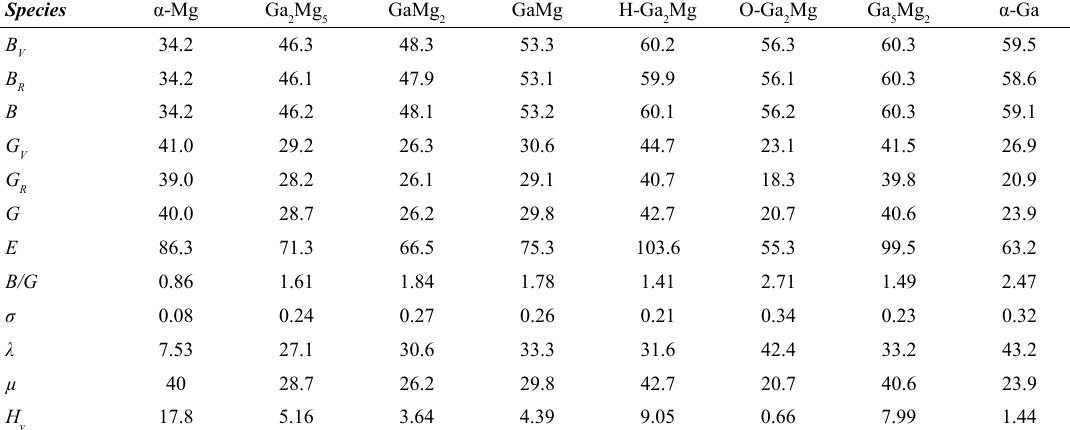
, in GPa) of Ga-Mg system. v